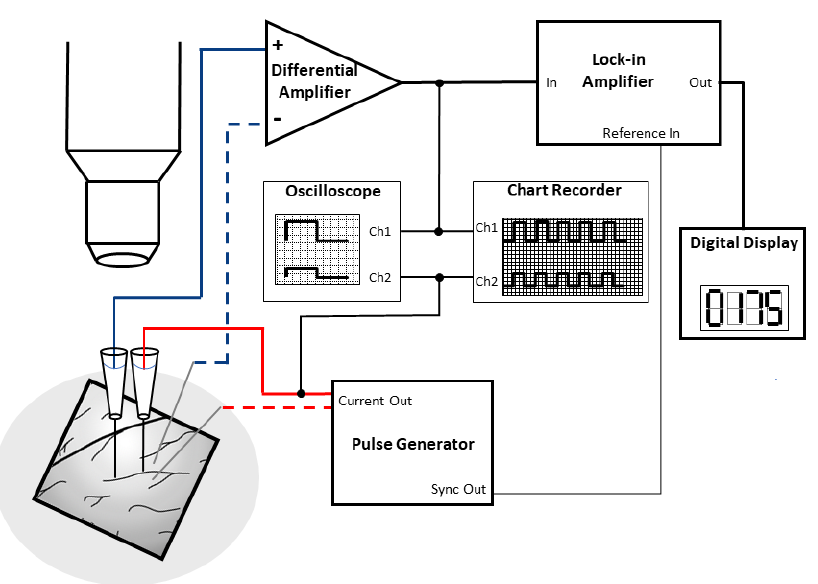
Figure 4. Cartoon explaining the in vivo electrical resistance measurement method of brain surface microvessels. On the left side, a cranial window allows the exposure of surface vessels for the measurement. From the two electrode pairs, one is for current injection (red), while the other one is for the potential measurement (blue) with rectangular pulses. The glass microelectrodes are filled with KCl buffer. Recordings are helped by a lock-in amplifier and an oscilloscope. Electrode insertion is controlled by precision observation using a microscope. Modified from [3].